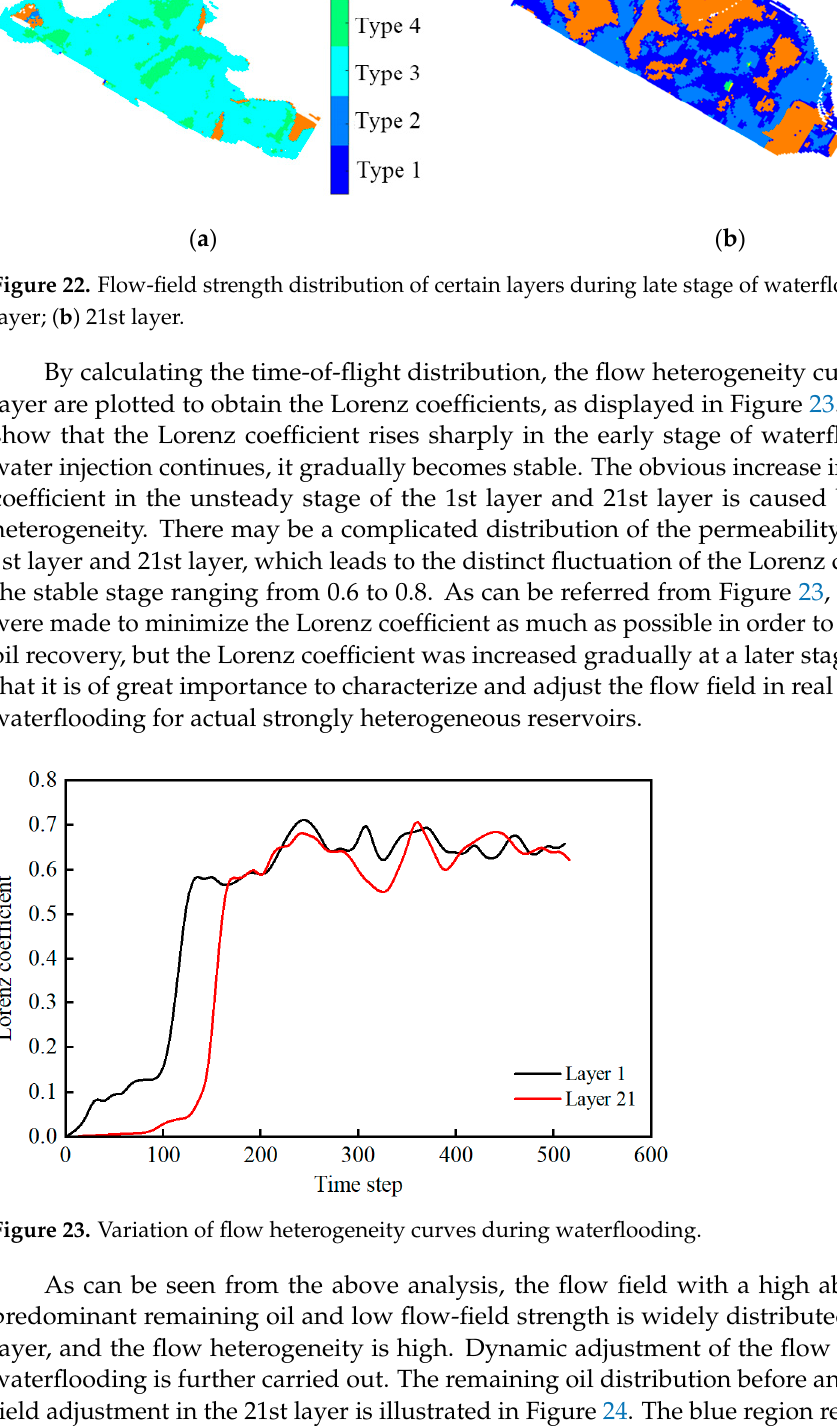
( b ) Figure 24. Remaining oil distribution before and after flow-field adjustment in the 21st layer. ( a ) Before adjustment; ( b ) after adjustment. The production performance before and after the adjustment of the flow field in the 21st layer is plotted in Figure 25. The oil recovery ratio and water cut are consistent with each other in the early stage of flow-field adjustment, and an obvious effect of oil increas- ing and water decreasing in the middle and later stages can be achieved. The optimized injection and production parameters have effectively improved the water flooding per- formance, but the magnitude of enhanced oil recovery is limited. When the reservoir en- ters a high or extra-high water-cut period, the injection of chemical agents, e.g., polymer and cross-linked gel, can be treated as a good alternative to further tap the remaining oil.